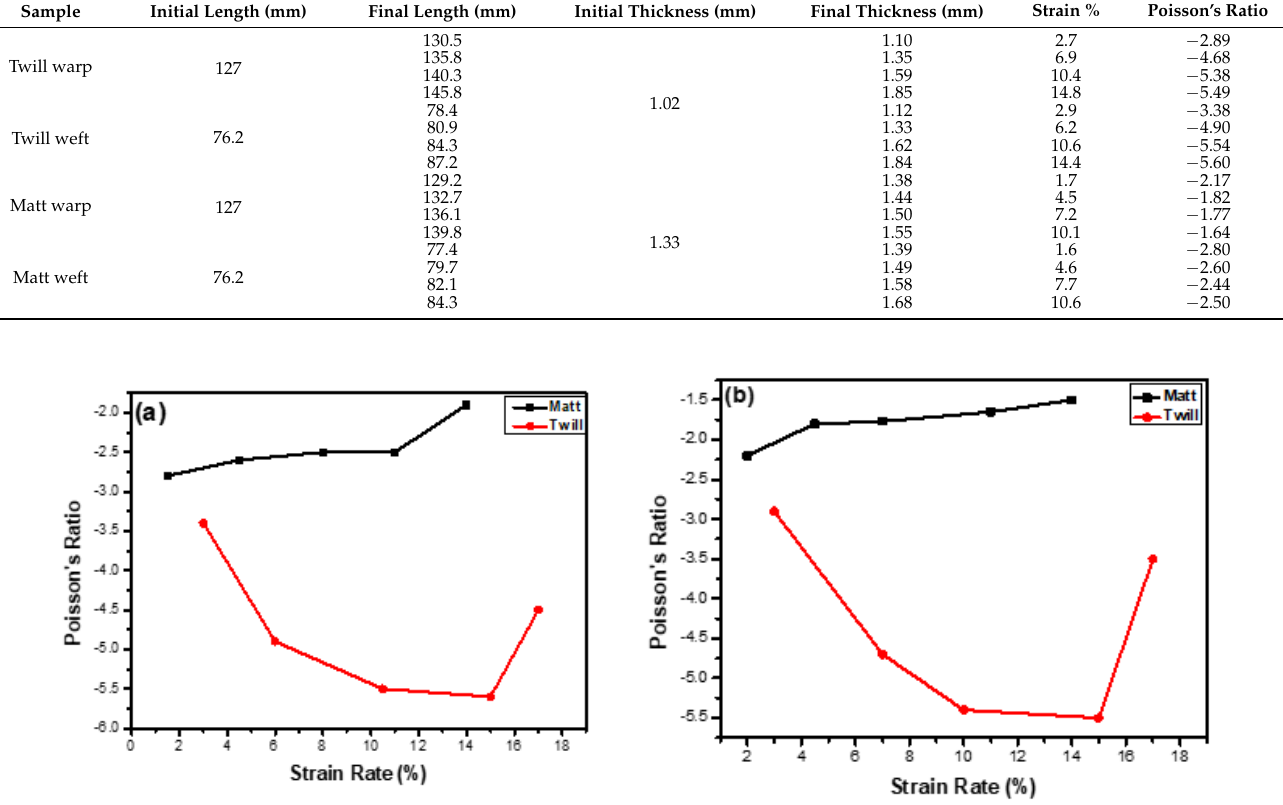
Table 4. Out-of-plane thicknesses with NPR and corresponding strain rates.